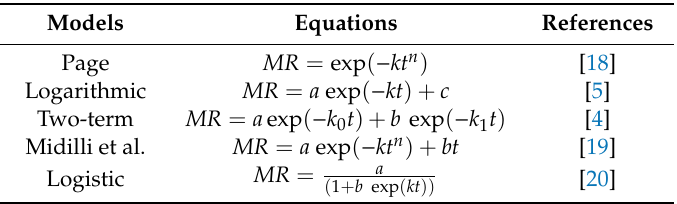
Table 2. Mathematical models for the prediction of the drying